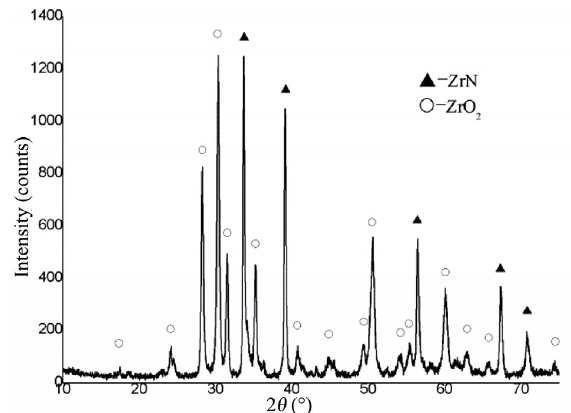
Fig. 1 XRD pattern of the sample with ZrN:ZrO 2 = 1:1.